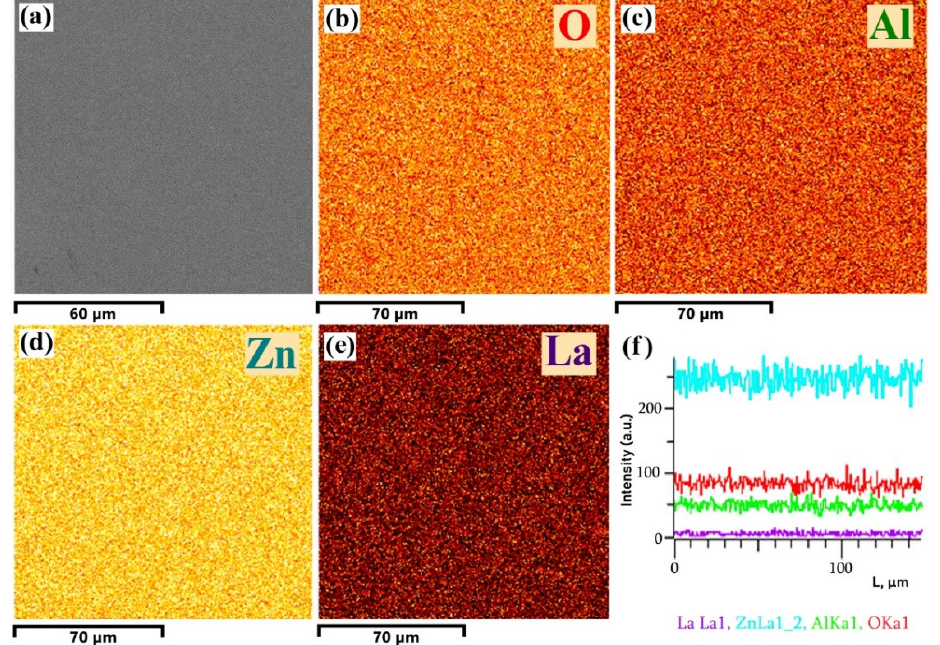
Figure 8. ( a ) SEM image, ( b – e ) EDX elemental mapping analysis of Zn, Al, O, and La, and ( f ) X-ray intensity of characteristic lines of different elements.